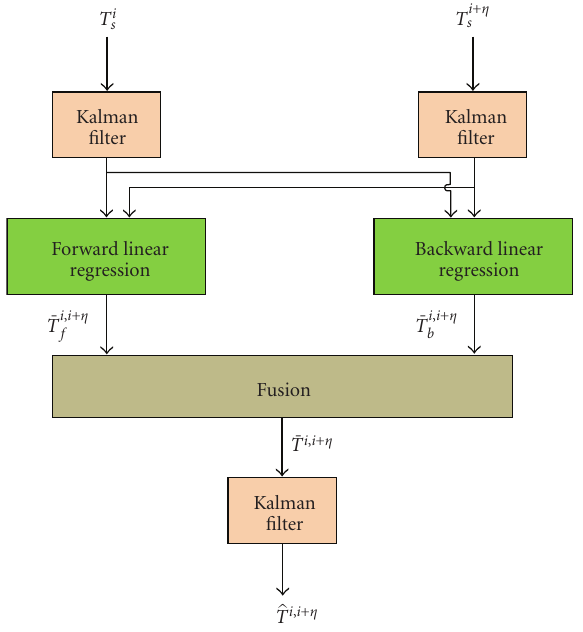
Figure 3: Trajectory estimation process for the unobserved region between camera C i and C i + η .